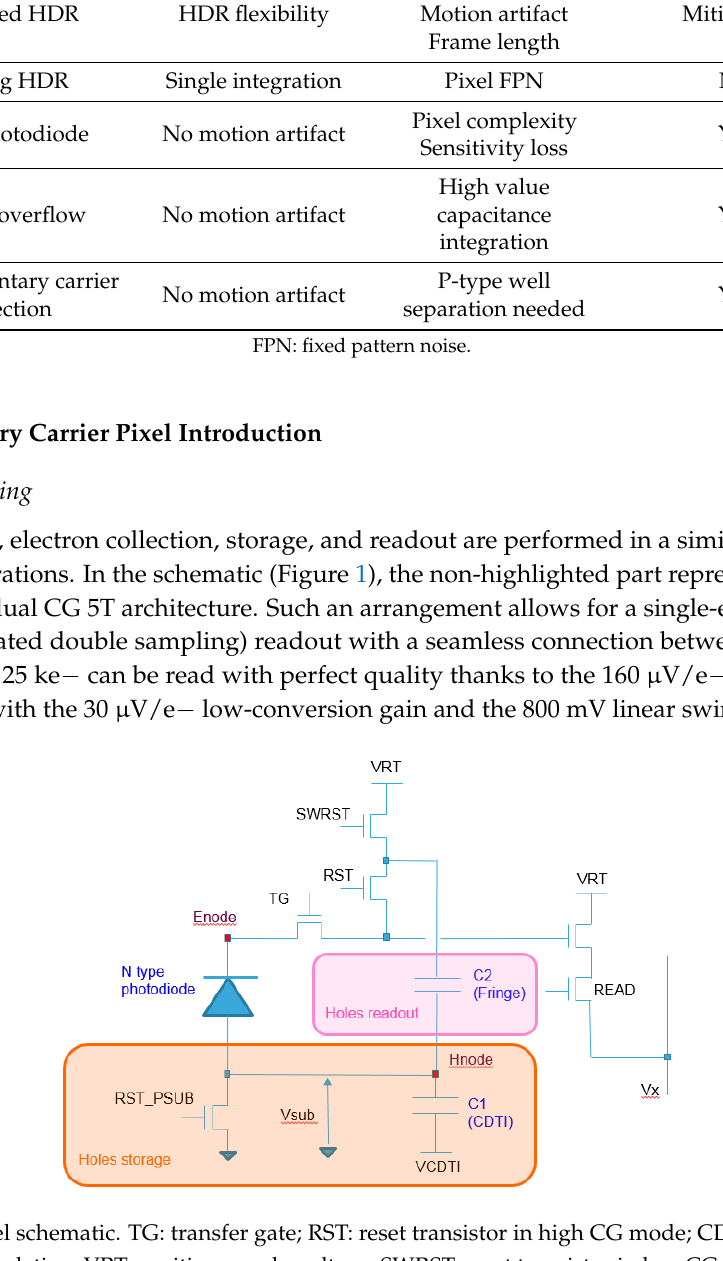
Table 1. High dynamic range (HDR) approach comparison.